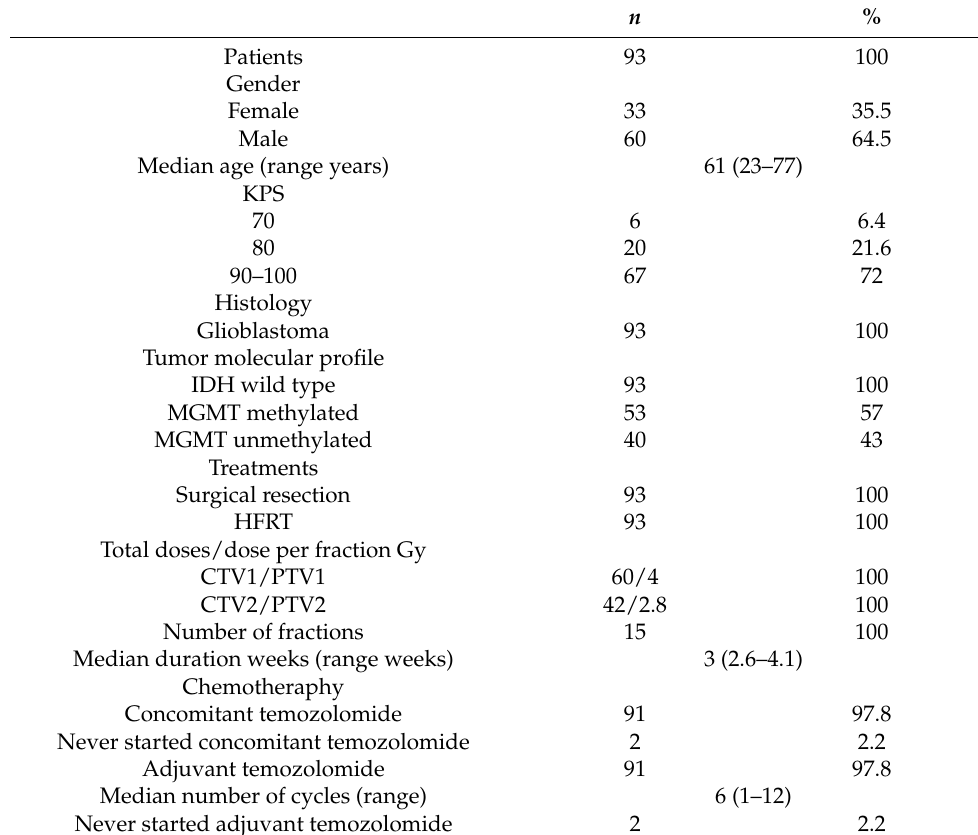
Table 1. Patient, tumor and treatment characteristics.